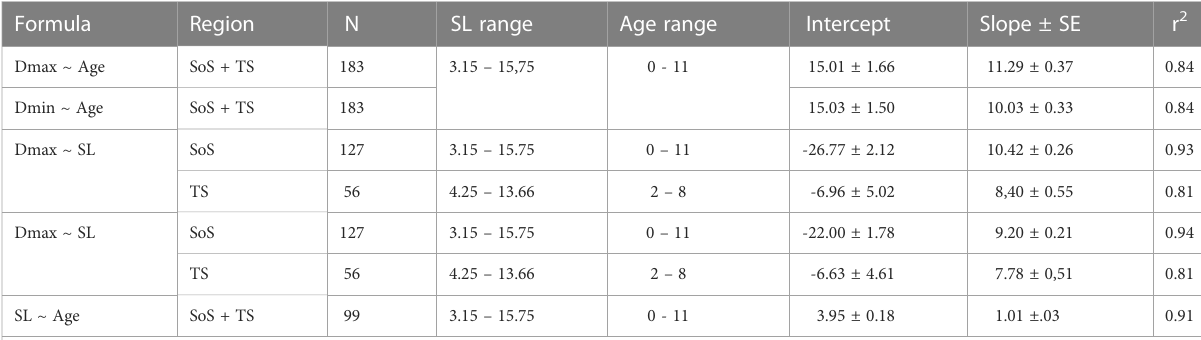
TABLE 1 Linear regression estimates of larval growth. N indicate the number of observations. Formula